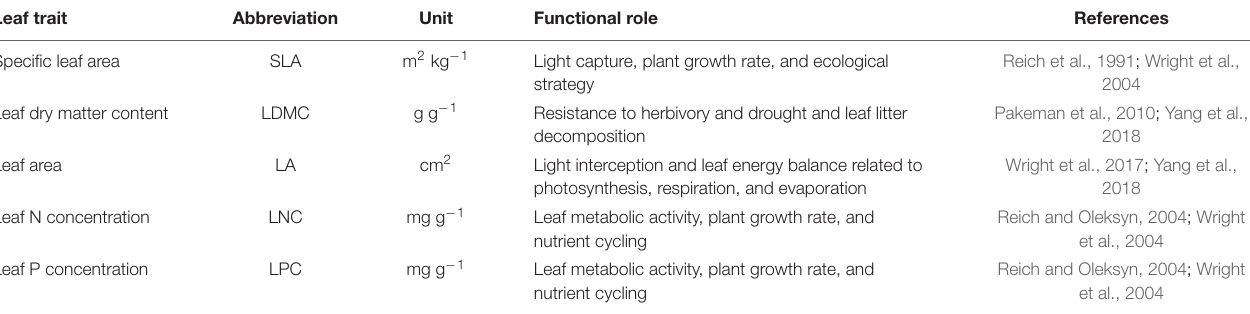
TABLE 1 | Description of the five leaf traits